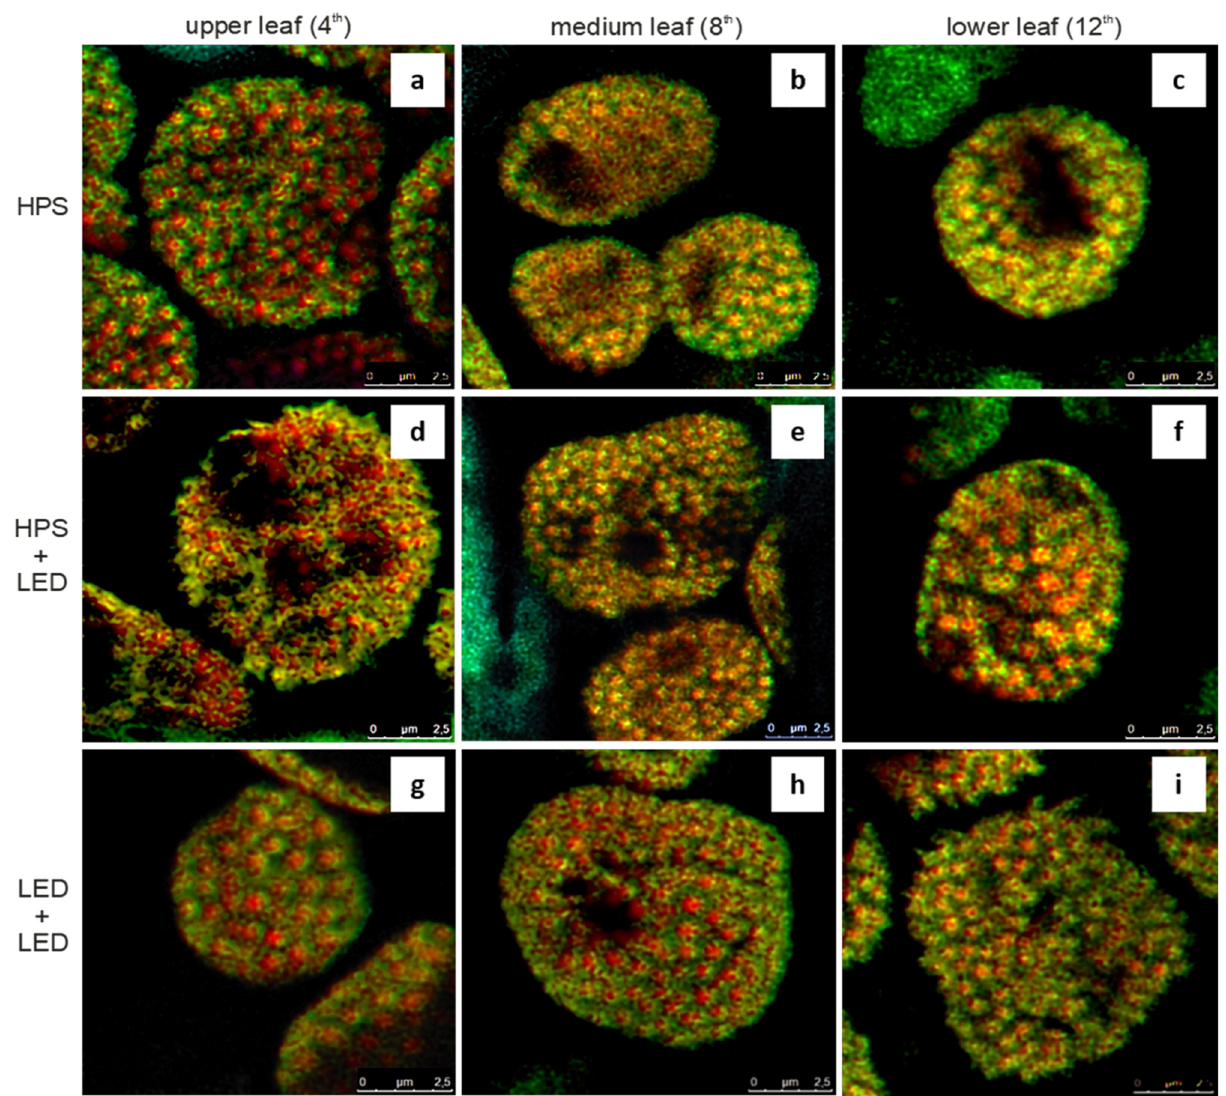
Figure 3. Confocal microscopy investigations: merged red and green channels representing chloro- phyll and carotenoid fluorescence, respectively, in the upper view of chloroplasts of cucumber leaves exposed to different light conditions. ( a ) HPS, upper leaf; ( b ) HPS, medium leaf; ( c ) HPS, lower leaf; ( d ) HPS + LED, upper leaf; ( e ) HPS + LED, medium leaf; ( f ) HPS + LED, lower leaf; ( g ) LED + LED, upper leaf; ( h ) LED + LED, medium leaf; ( i ) LED + LED, lower leaf. Yellow colour represents high correlation between both fluorescence signals. Abbreviations: HPS—high-pressure sodium lamps used as toplighting; HPS + LED—HPS toplighting and LED interlighting; LED + LED—light-emitting diode lamps used as toplighting and interlighting. Bars = 2.5 µm.